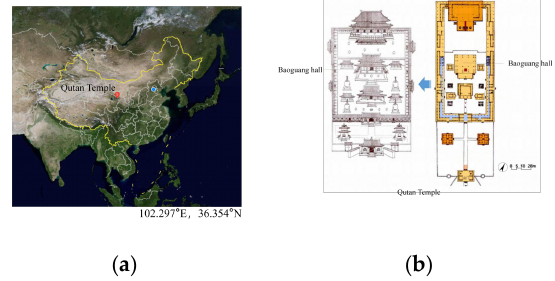
Figure 1 . (a) Qutan Temple is located in Ledu County, Qinghai Province; (b) the location of Baoguang hall in Qutan